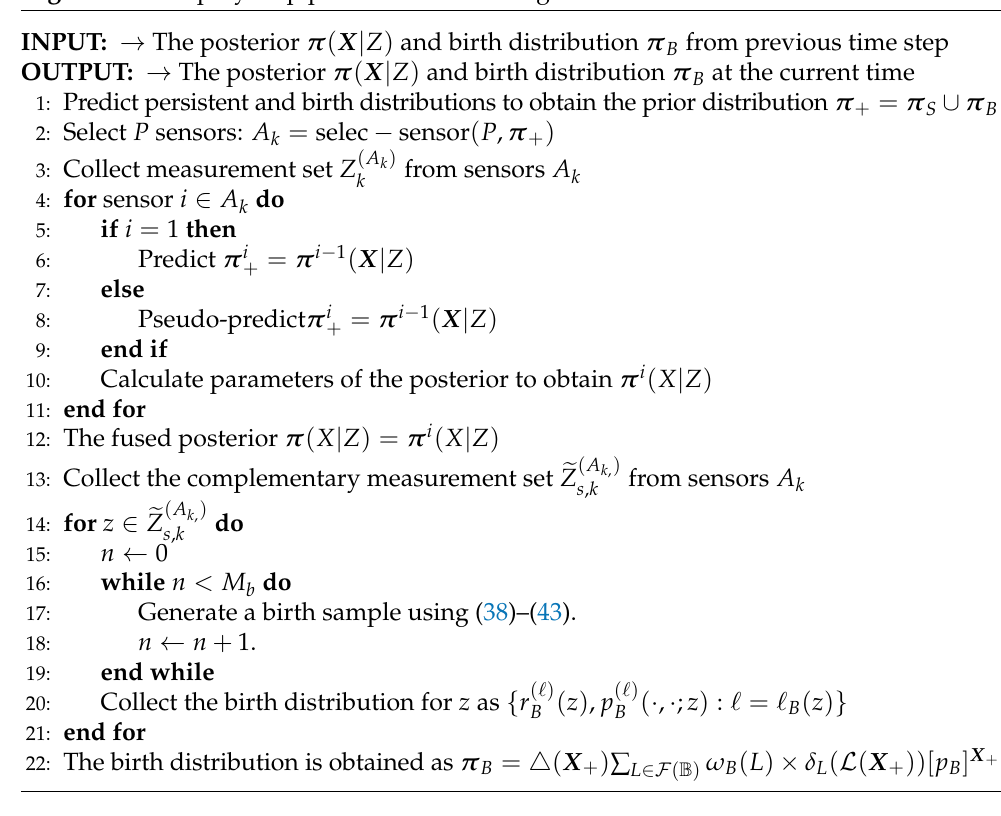
Algorithm 1 Step-by-step pseudocode for a single run of the CAR-GLMB